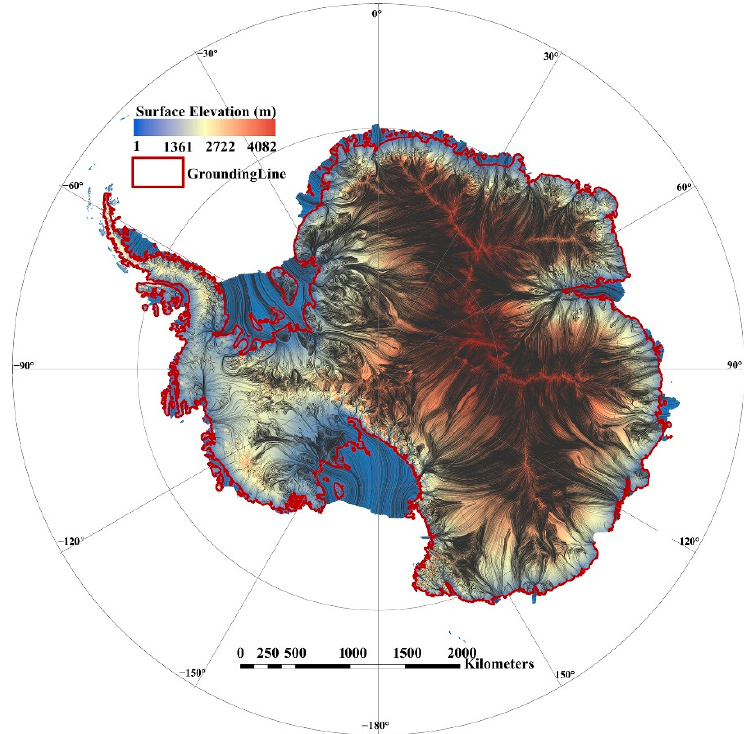
Figure 11. Overview of the extracted ice flow line map by the proposed method. Bedmap2 elevation data is used as background for better visualization. data is used as background for better